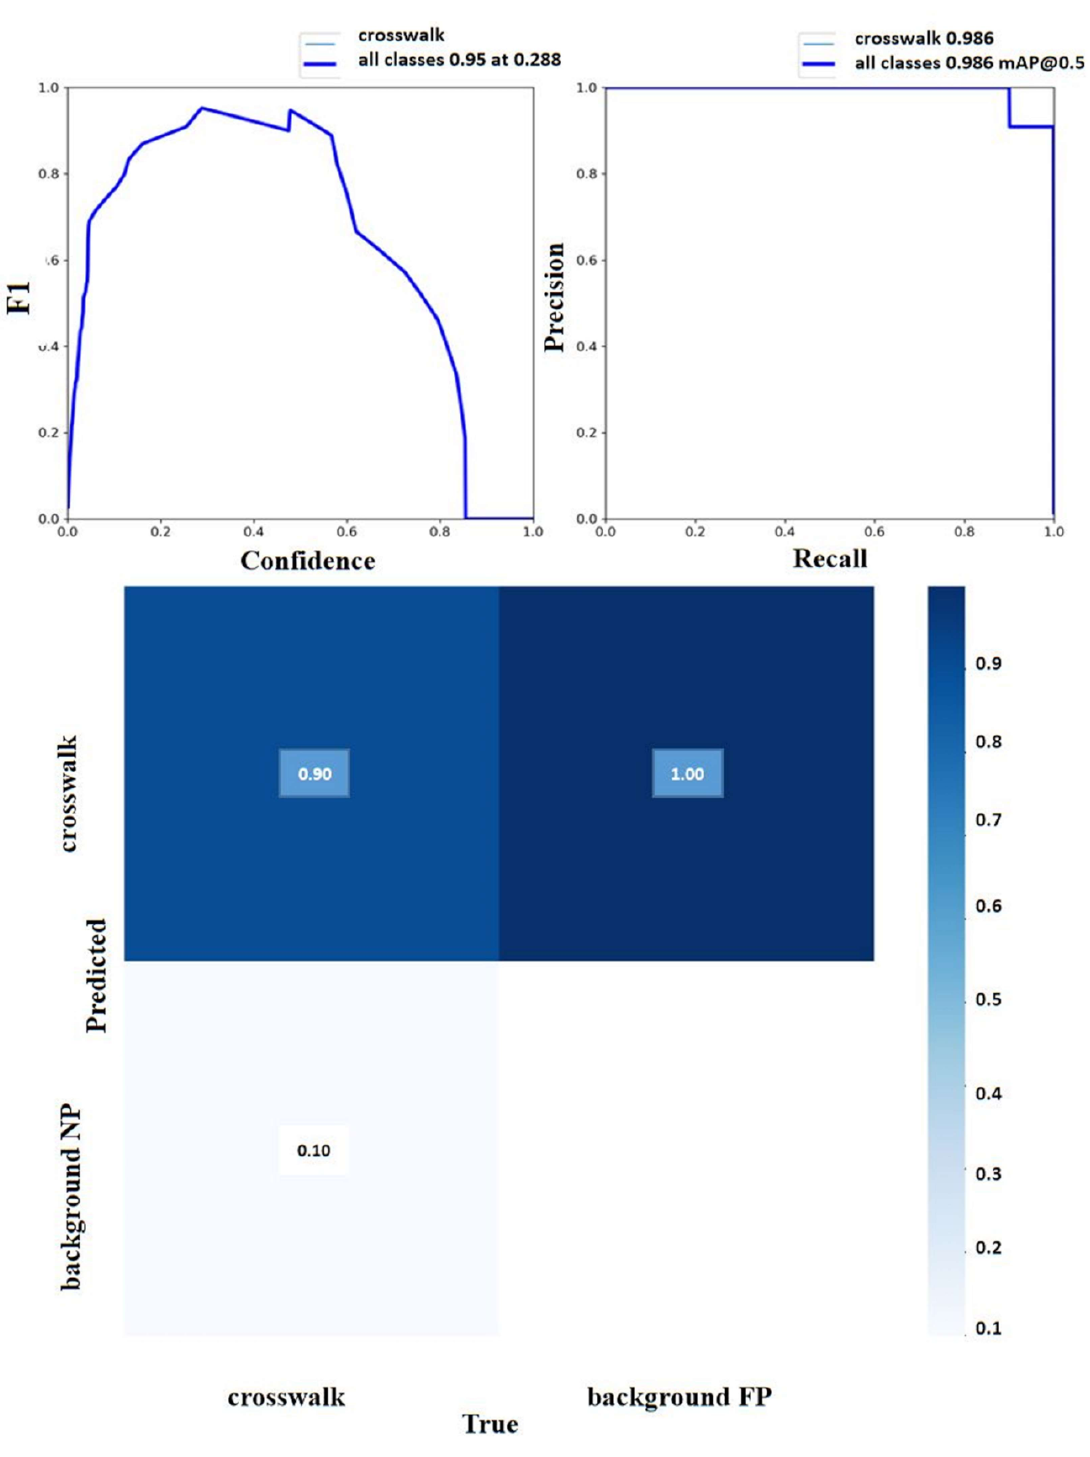
Figure 7. F1 score, PR curve, and confusion matrix of YOLOv7 for the CRWALK